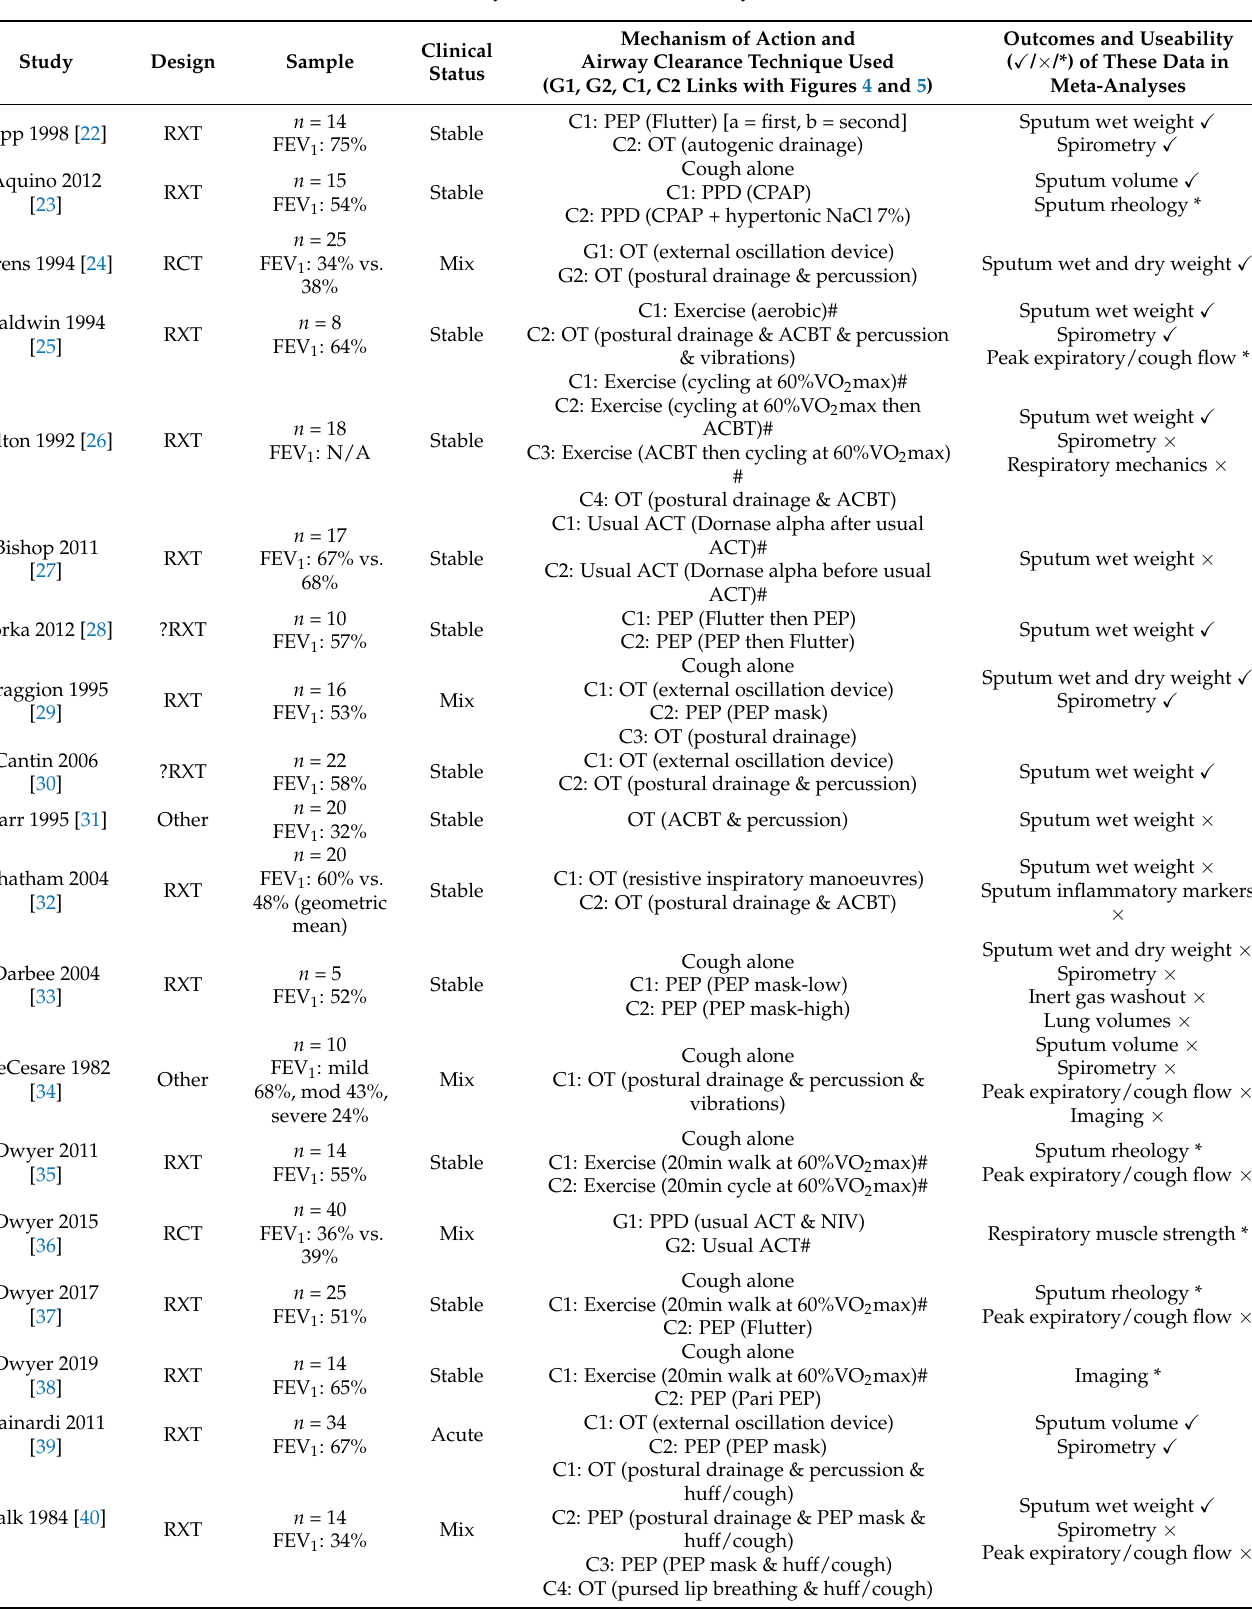
Table 1. Summary of studies included in systematic